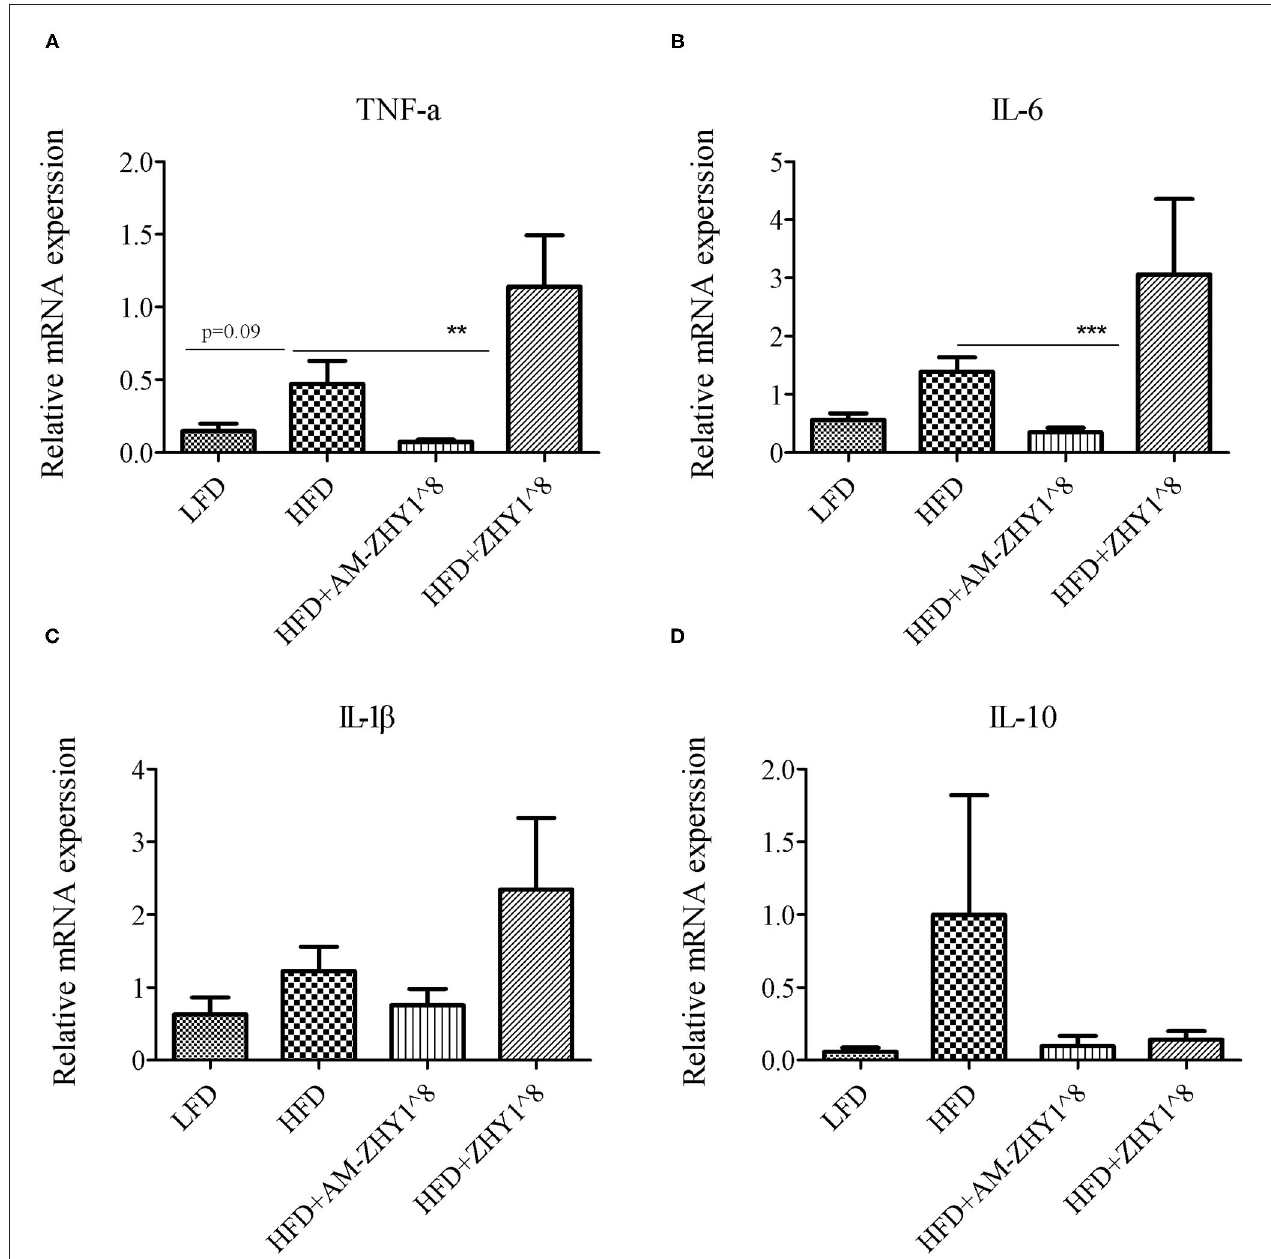
FIGURE 7 | Relative mRNA expression of inflammation related genes: TNF α (A) , IL-6 (B) , IL-1 β (C) , IL-10 (D) of liver of zebrafish of different groups. Data are presented as mean ± SEM ( n = 6). The asterisks on the horizontal line represent significant differences between the two groups. ** p < 0.01, *** p < 0.001.